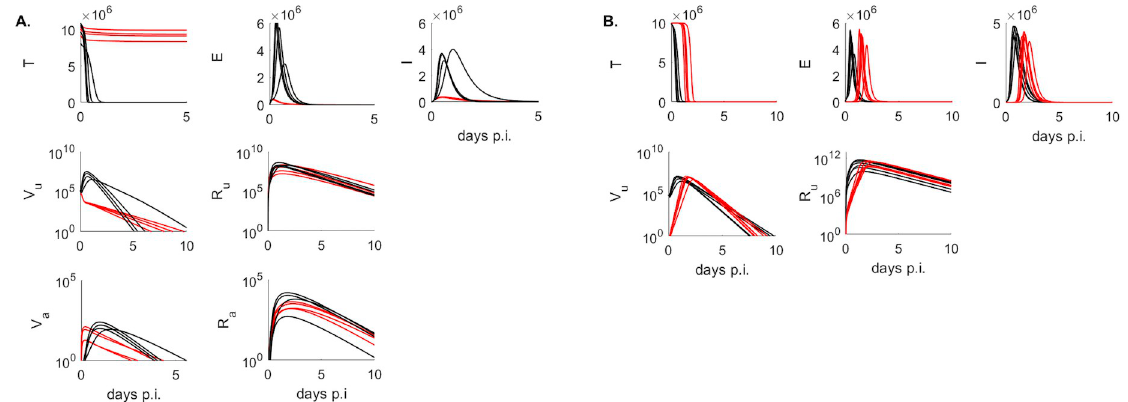
Fig 6. Population dynamics of model variables. Population dynamics of T , E , I , V u , R u , V a and R a as given by models Eqs 3 and 4 in (A.) males (back) and females (red) and (B.) donors (black), contacts with fixed inoculum V 0 = 1 TCID 50 (red). Model parameters are given in Tables 1 and